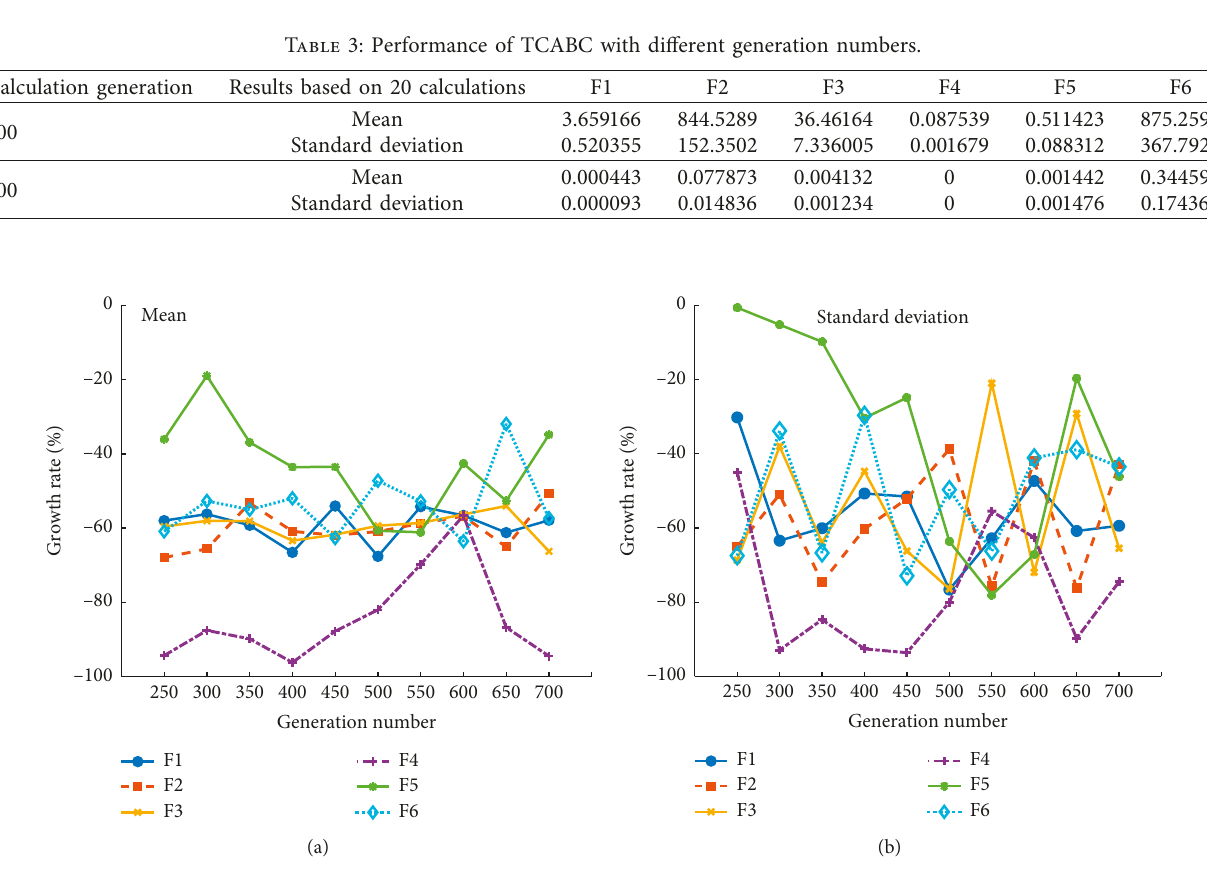
Figure 5: The growth rate of the TCABC algorithm with different generations for (a) mean and (b) standard